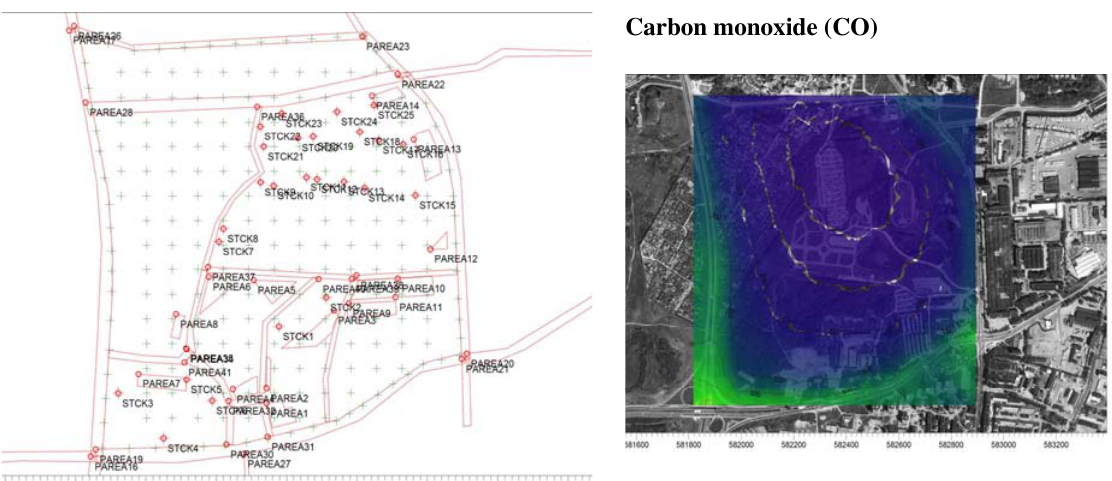
Fig 4 . Graphic view of pollutant dispersion modeling (CO)